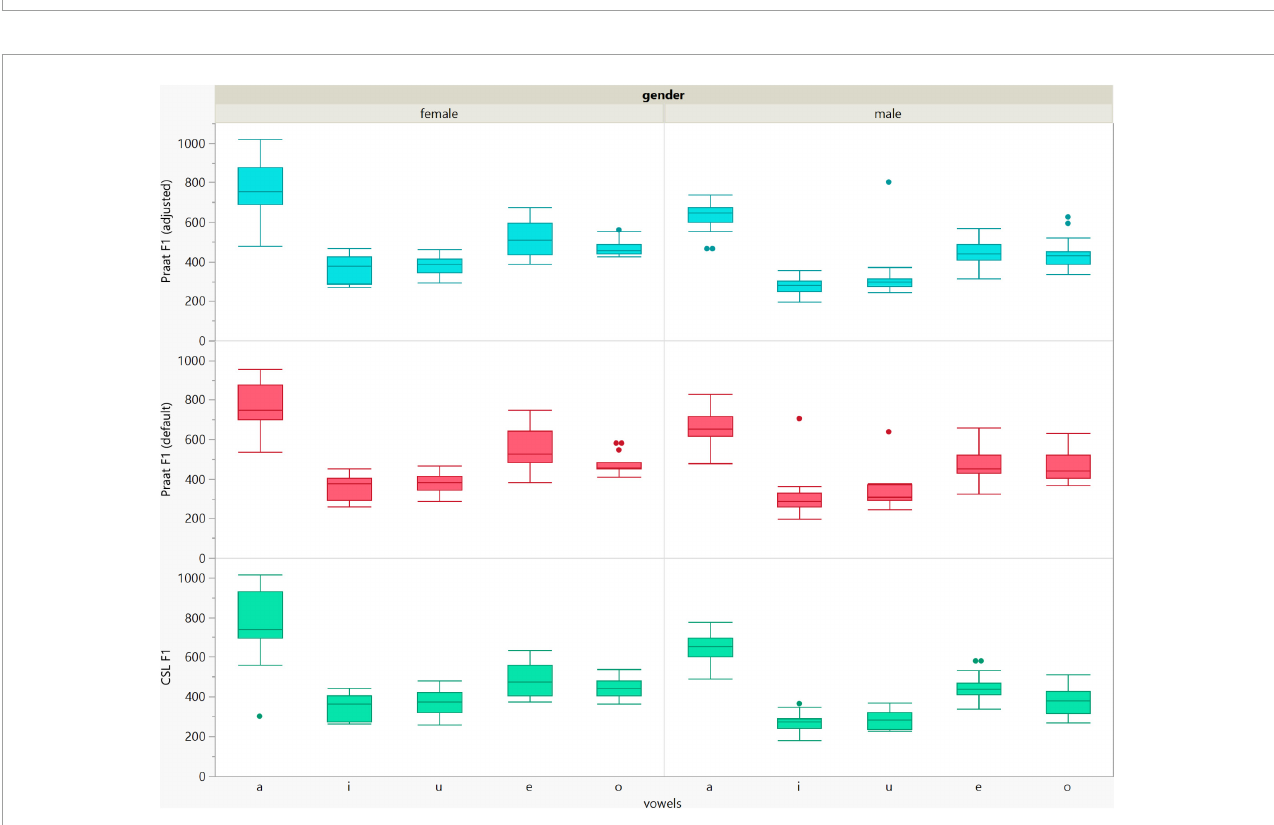
FIGURE5 Box plots of the F1 data of the five vowels calculated using Computerized Speech Lab (CSL) and Praat with the default and adjusted settings for both men and